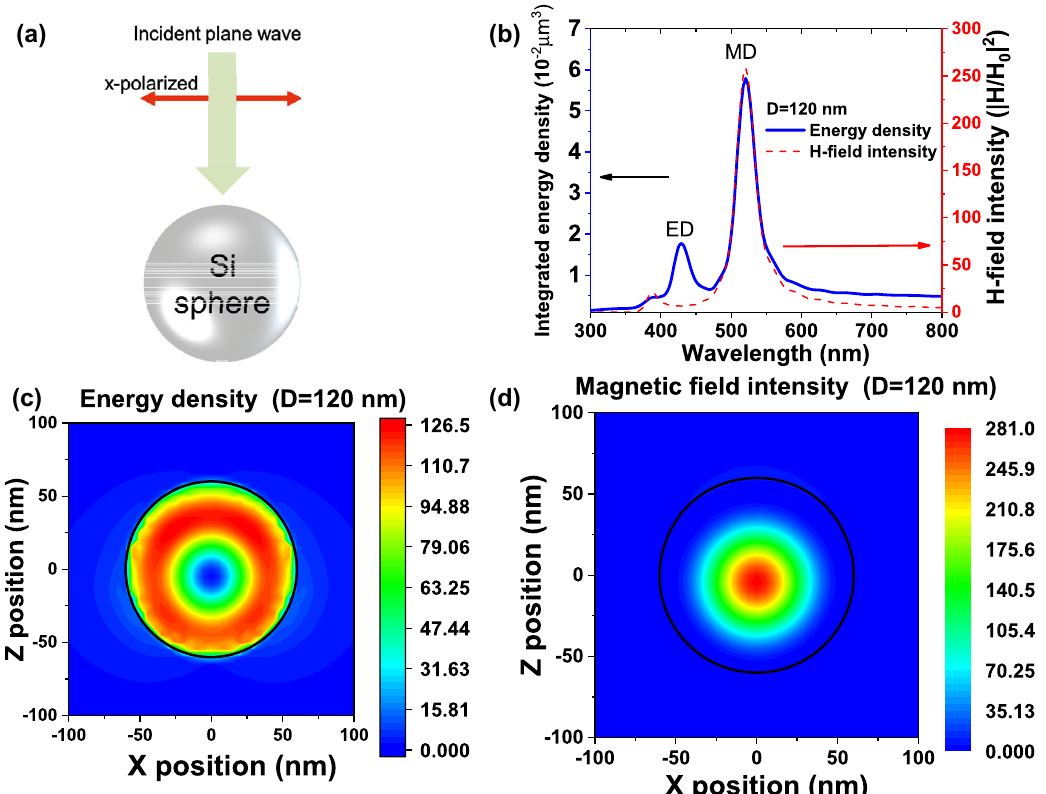
Figure 1: (a) Schematic representation of a freestanding Si sphere illuminated by plane wave. (b) Simulated integrated energy density and | 2 ) of a freestanding Si sphere ( D = 120 nm). (c, d) energy density distributions (c) and magnetic field intensity magnetic field intensity ( | H / H 0 in the x – z plane of the Si sphere at wavelength of 521